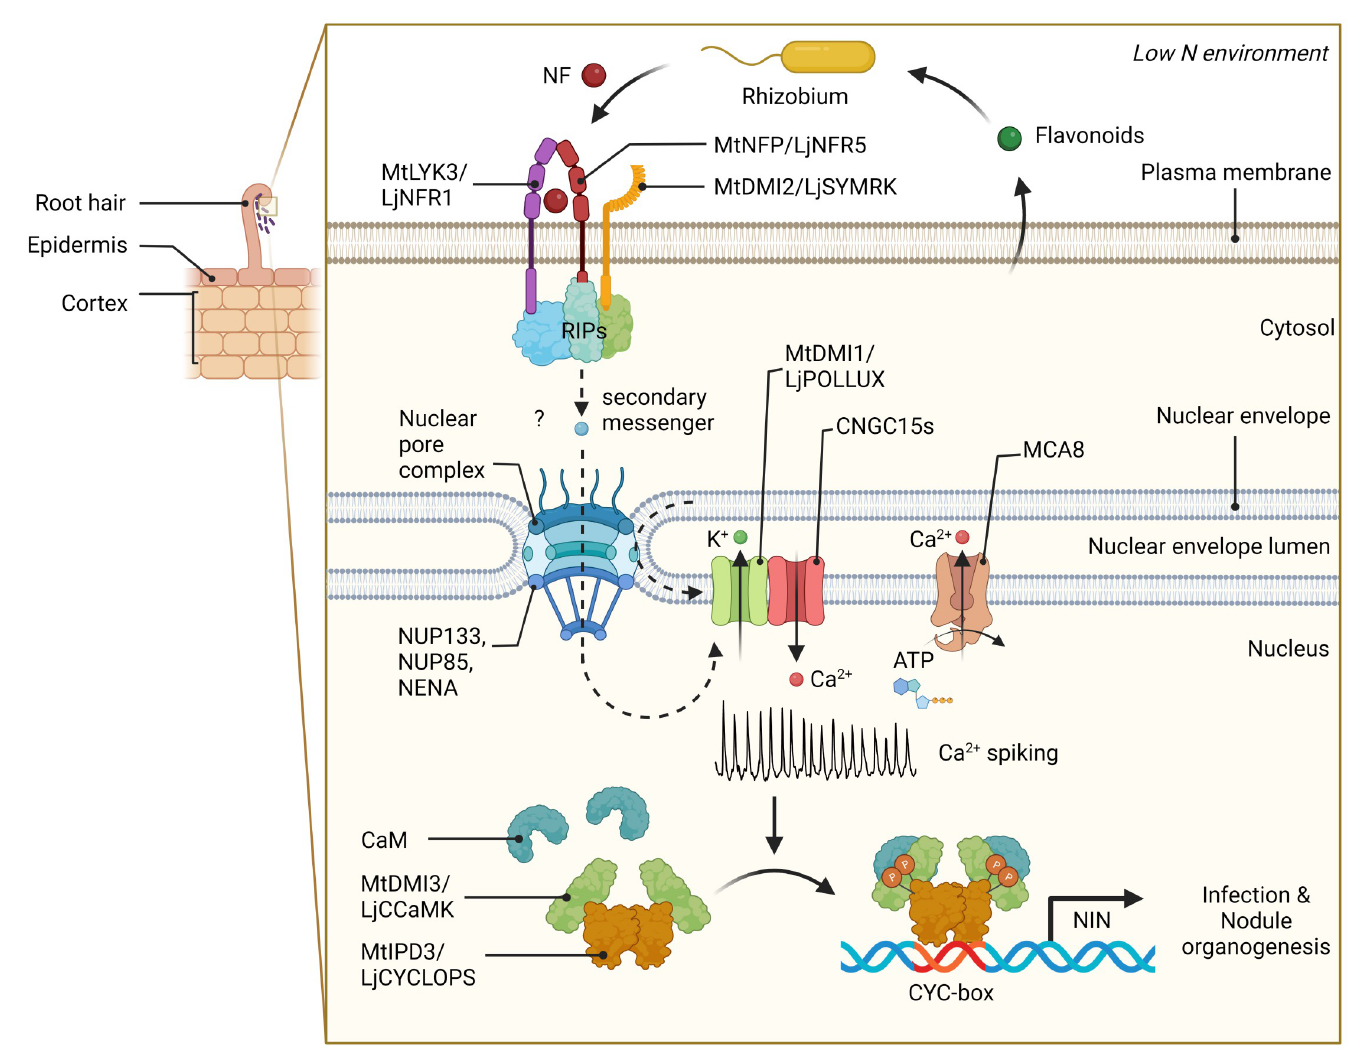
Fig 1. NF perception and the common symbiosis signalling pathway. Flavonoid exudates from legume roots act as signals to relevant rhizobia in the soil, activating production of NF. A receptor complex at the root surface allows NF recognition, through binding to LysM receptor kinases LYK3 (also known as NFR1) and NFP (also known as NFR5), coupled to the LRR-containing receptor kinase SYMRK (also known as DMI2) that activates downstream signalling. A number of RIPs have been identified that may facilitate downstream signal transduction including ROP-GTPases and GEFs, which are particularly associated with rhizobial infection; a group of receptor-like cytoplasmic kinases, which includes SYMRK INTERACTING PROTEINS and the NFR5-INTERACTING CYTOPLASMIC KINASE4 that can activate phosphorylation cascades; and a HMGR, which interacts with SYMRK and induces the production of mevalonate. The action of one or many of these RIPs may produce a secondary messenger that links receptor activation at the plasma membrane to induction of cation channels on the nuclear envelope. The cyclic nucleotide-gated channels CNGC15s release calcium from the nuclear envelope lumen into the nucleus, while other cation channels are required for symbiotic calcium spiking, CASTOR and POLLUX (also known as DMI1): DMI1 interacts with CNGC15 and appears to coordinate the release of calcium from this channel. The calcium ATPase MCA8 pumps calcium back into the nuclear envelope to maintain nuclear calcium homeostasis. Components of the nuclear pore complex, like NUP85, NUP133, and NENA, are also required for symbiosis signalling, and these are thought to direct the necessary channels onto the inner nuclear envelope. The coordinated action of the channels and pumps creates nuclear calcium oscillations that promote the CCaMK (also known as DMI3). CCamK/DMI3 phosphorylates CYCLOPS/IPD3, which, in turn, promotes symbiotic transcription, such as the induction of NIN . Gain-of-functions in NFR1 , NFR5 , SYMRK , DMI1 , CCaMK , and CYCLOPs , all autoactivate nodulation, demonstrating that activation at any point in this pathway is necessary and sufficient for nodule initiation. Created with BioRender.com. CaM, calmodulin; CCaMK, calcium and CaM-dependent serine/threonine protein kinase; DMI2, DOES NOT MAKE INFECTIONS 2; GEF, Guanine-nucleotide Exchange Factor; HMGR, 3-hydroxy-3-methylglutaryl-CoA reductase; IPD3, INTERACTING PROTEIN OF DMI3; Lj, Lotus japonicus ; LysM, lysine motif; Mt, Medicago truncatula ; NF, Nod factor; NIN, NODULE INCEPTION; NUP, NUCLEAR PORE COM-PLEX PROTEIN; RIP, receptor-interacting protein; ROP-GTPase, Rho of plants–guanosine triphosphatase.